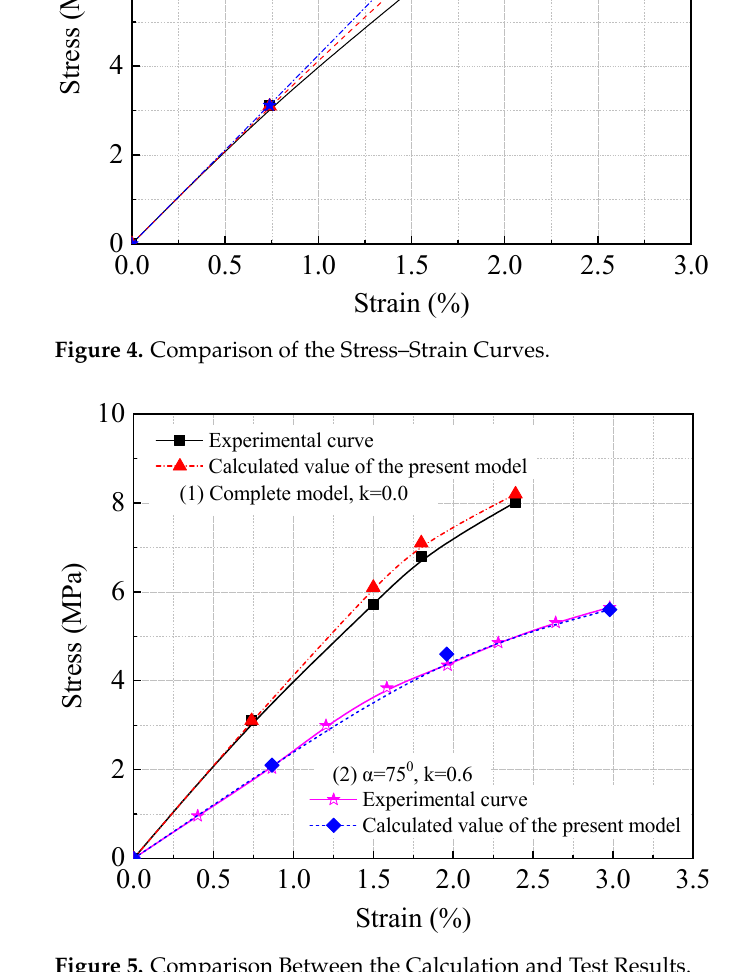
Figure 5. Comparison Between the Calculation and Test Results.